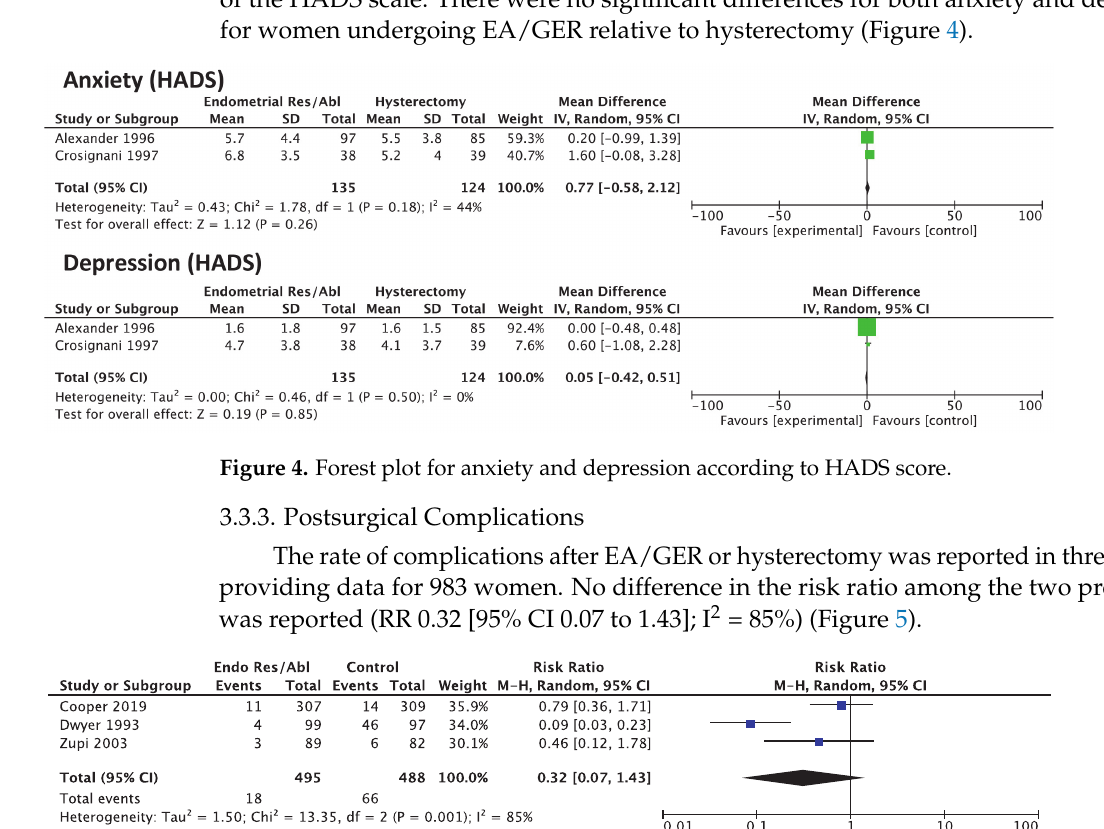
Figure 3. Forest plot for the primary outcome (QoL) evaluated using SF ‐ 36 score.